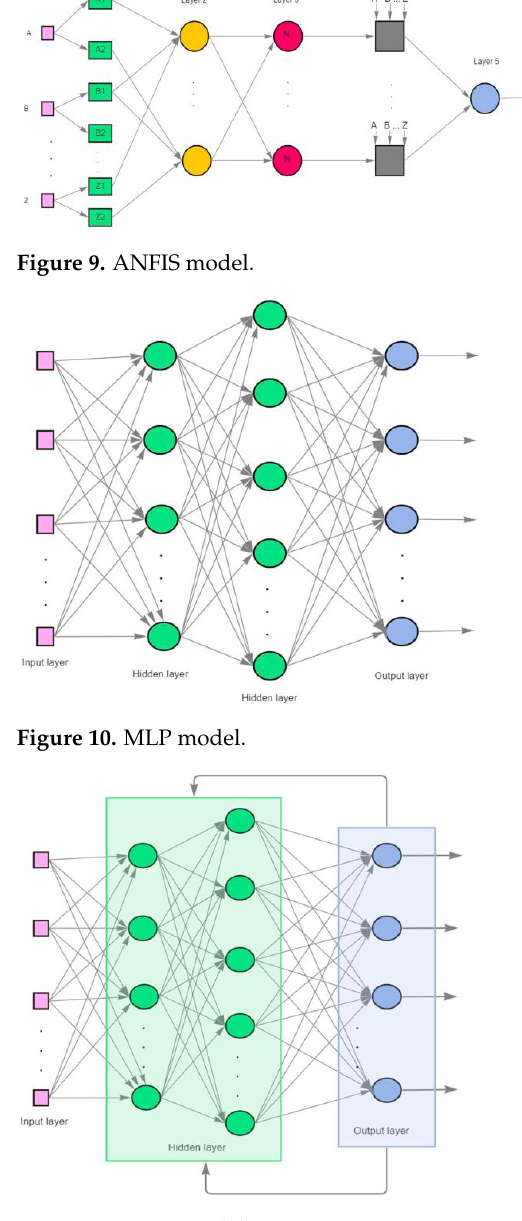
Figure 12. CNN model. Figure 13. Bidirectional LSTM model. Figure 14. LSTM general structure.